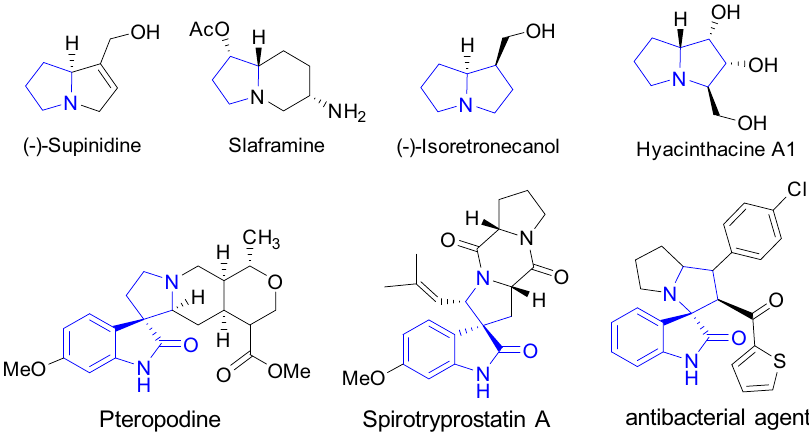
Figure 1: Bioactive pyrrolidine, pyrrolizidine, and spirooxindole - pyrrolidine compounds.